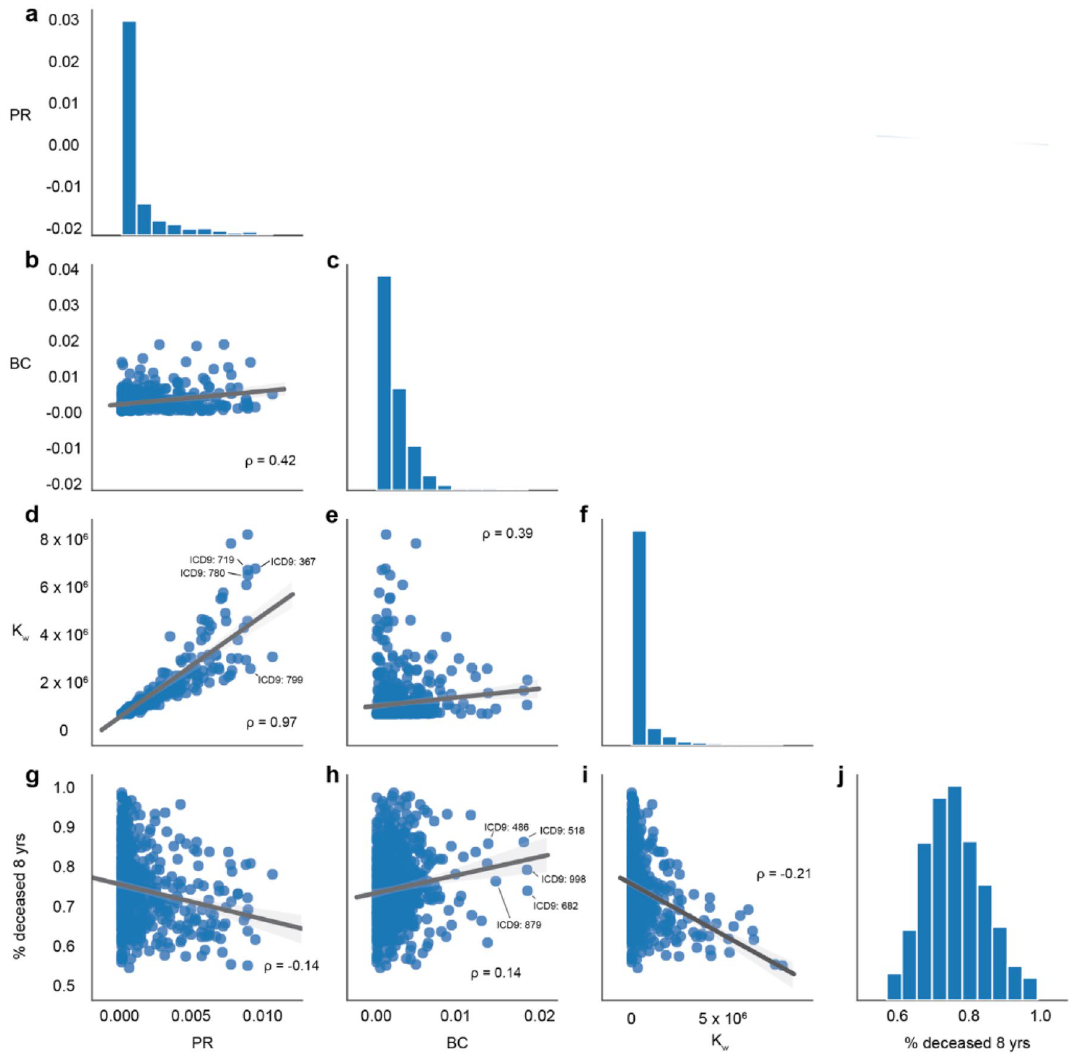
Figure 2. Network centrality and fatality. Comparison of network centrality and fatality values across nodes of the Disease Network. Inset numbers represent the Spearman correlation coefficient (all with p <